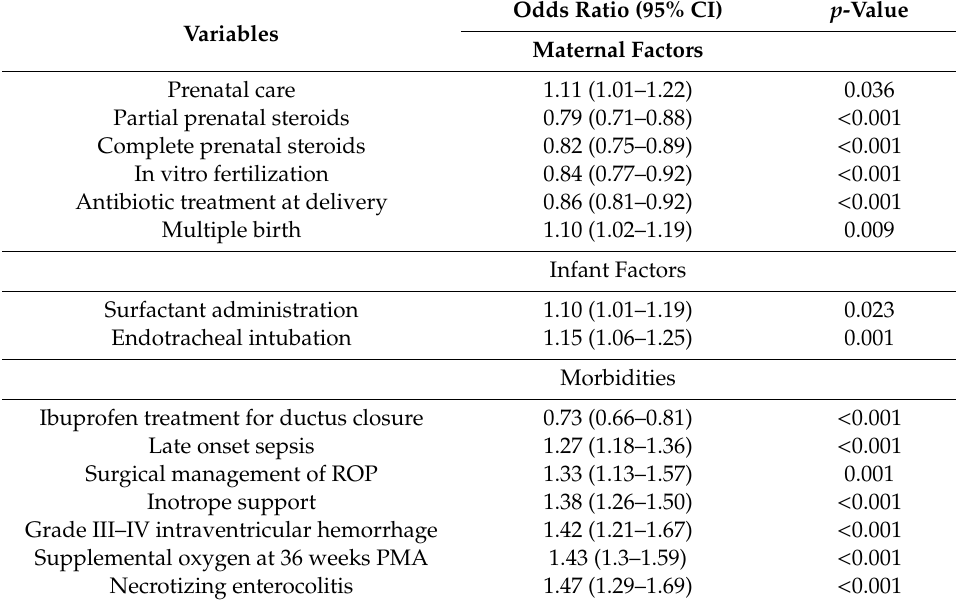
Table 4. Logistical regression analysis of no breastfeeding at discharge as a function of selected predictor